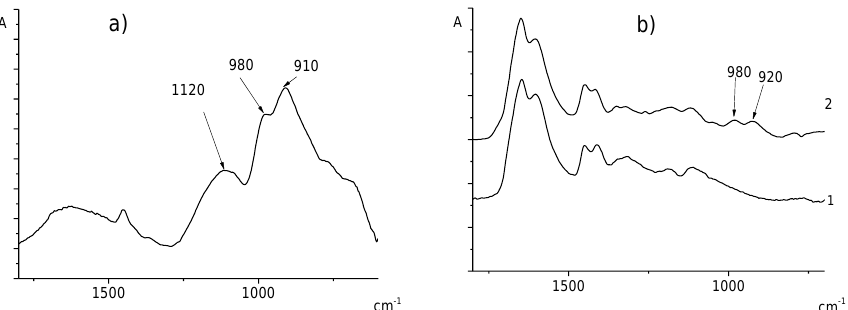
Figure 2. FTIR spectra of VPA homopolymer ( a ), AA homopolymer ( b ,1), AA-VPA copolymer (Experiment 11, Table 1) ( b ,2).